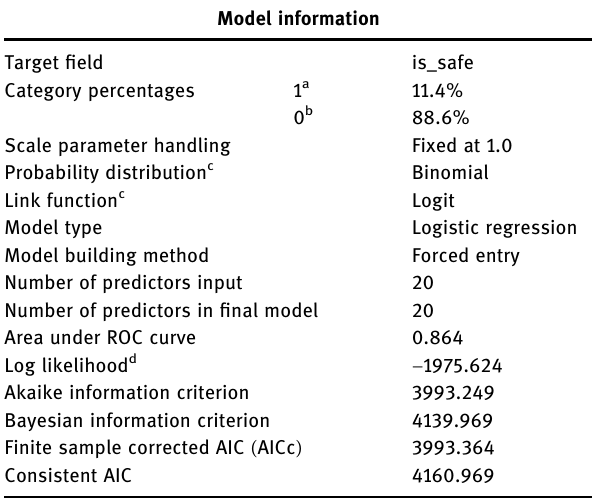
Table 1: Logistic